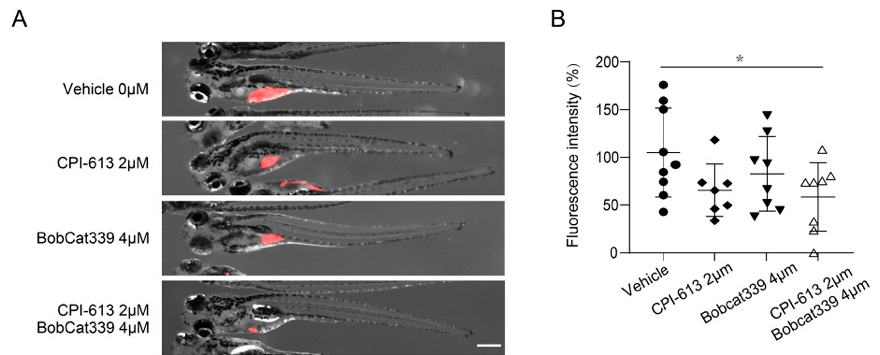
Figure 6. Combined inhibition of the TCA cycle and DNA methylation through CPI-613 and Bobcat 339 significantly decreases the tumor burden in zebrafish xenografts of human T-ALL. ( A ) Treatment of zebrafish xenografts with the TCA cycle inhibitor CPI-613 (2 μ M) or TET1/2 inhibitor Bobcat339 (4 µ M) resulted in a slightly decreased tumor burden, while combination treatment led to a significantly decreased tumor burden. ( B ) Quantification of the tumor fluorescence intensity in zebrafish xenografts is shown in ( A ). The data are presented as the mean ± s.e.m., and statistical differences are calculated using an unpaired two-tailed t -test with the vehicle as the control. Scale bar in ( A ) = 500 μ m. * p < 0.05.